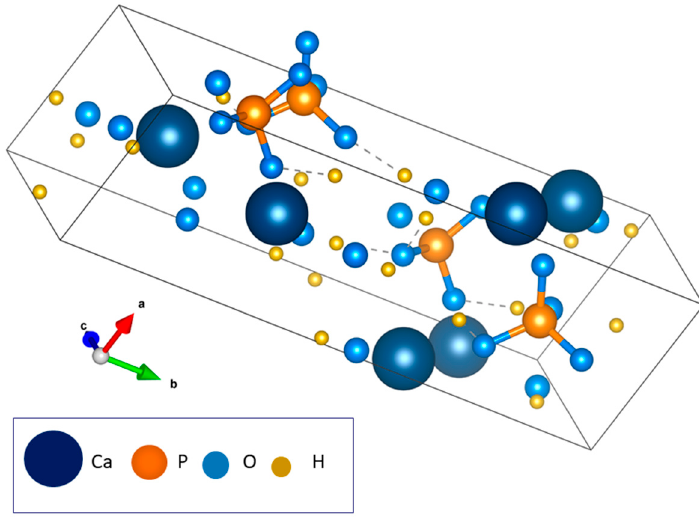
Figure 1. Crystalline structure of dicalcium phosphate dihydrate (DCPD).